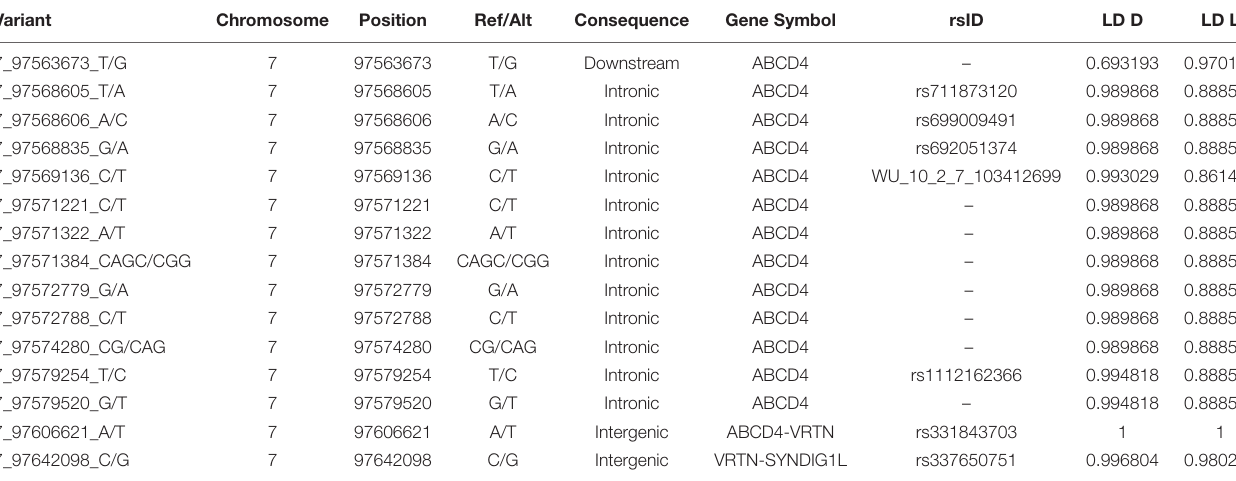
TABLE 4 | Identified variants on the same haplotype as VRTN insertion and promoter SNP. Variant